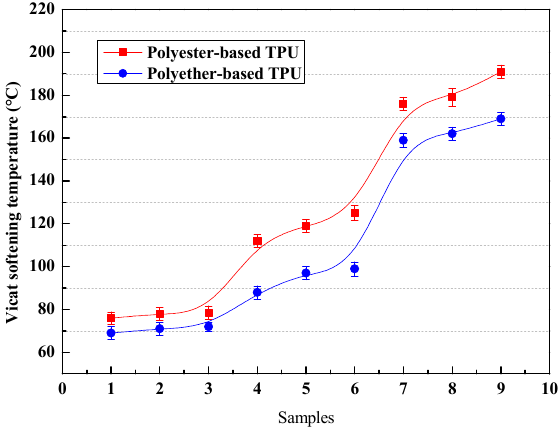
Figure 12. VST of polyester-based and polyether-based TPUs.